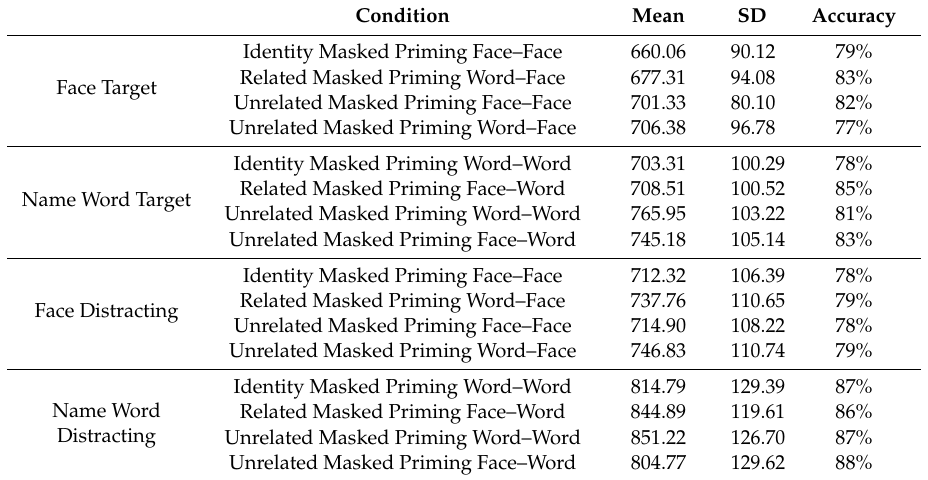
Table 2. Mean and SD (standard deviation), and accuracy rate for Experiment 2 across conditions.